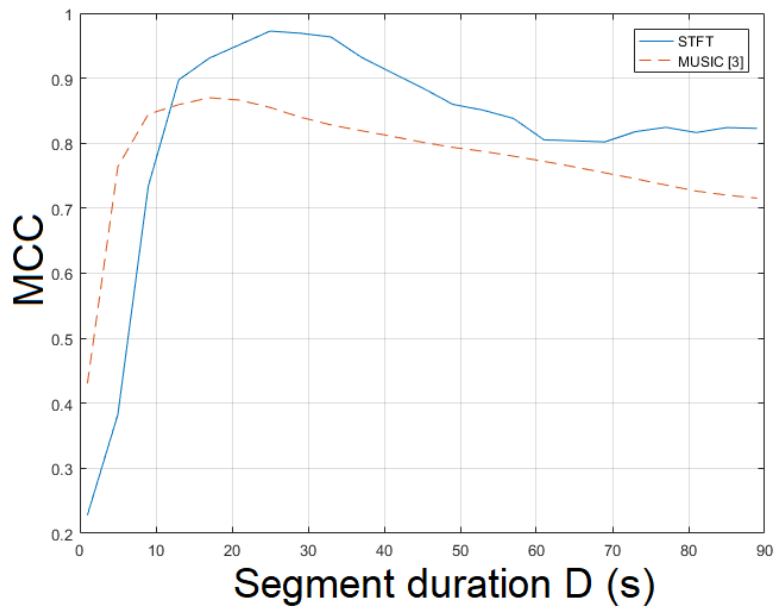
Figure 8. Maximum correlation coefficient of the proposed approach employing SLIC+STFT for various segment durations against the MUSIC [3]